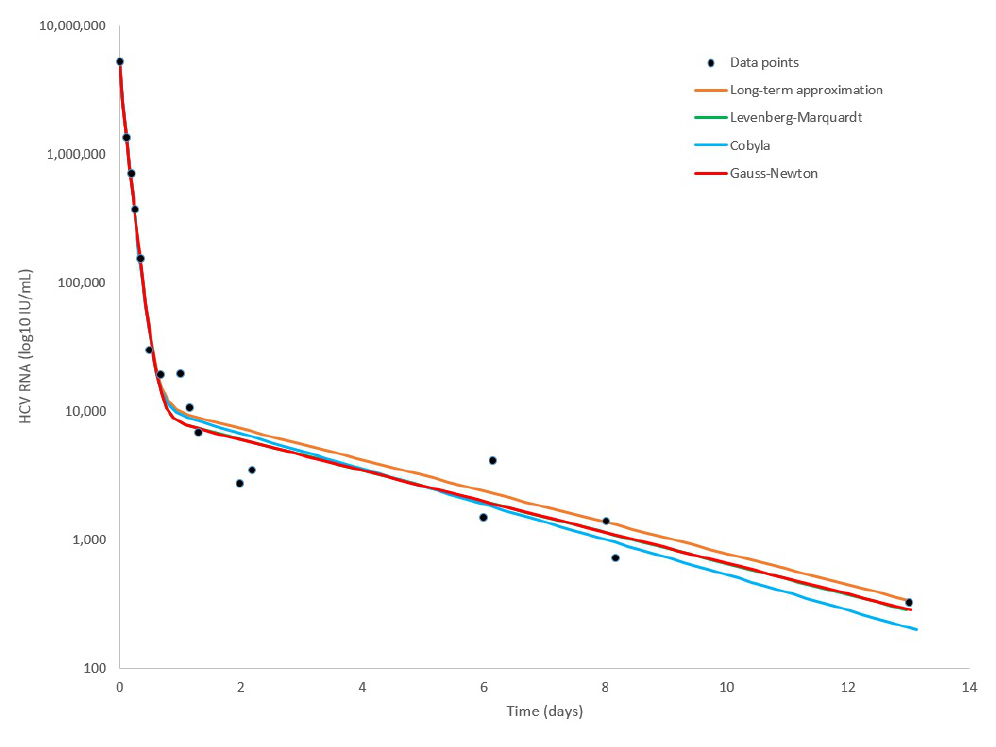
Figure 6. Comparison between the line fits of different methods for the retrieved data points of patient HD that was reported in